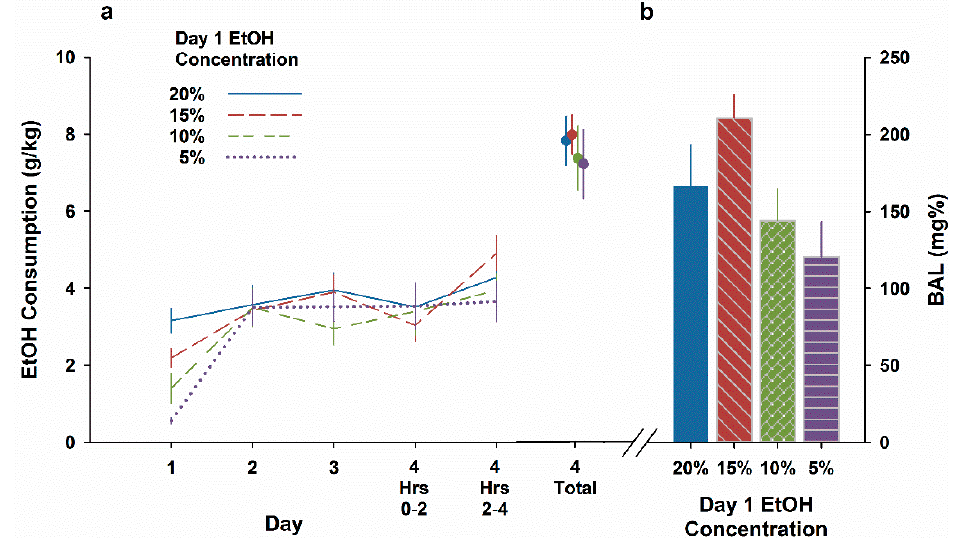
Figure 2. No effect of initial day EtOH dose ingested on subsequent drinking in the dark drinking in HDID-1female mice. ( a ) Drinking for two hour periods on Days 1–4 and total dose ingested in 4 h on Day 4. ( b ) Blood alcohol levels at 4 h on Day 4. Mean ± SEM for groups of 14 mice per Day 1 concentration. All mice drank 20% EtOH on Days 2–4.